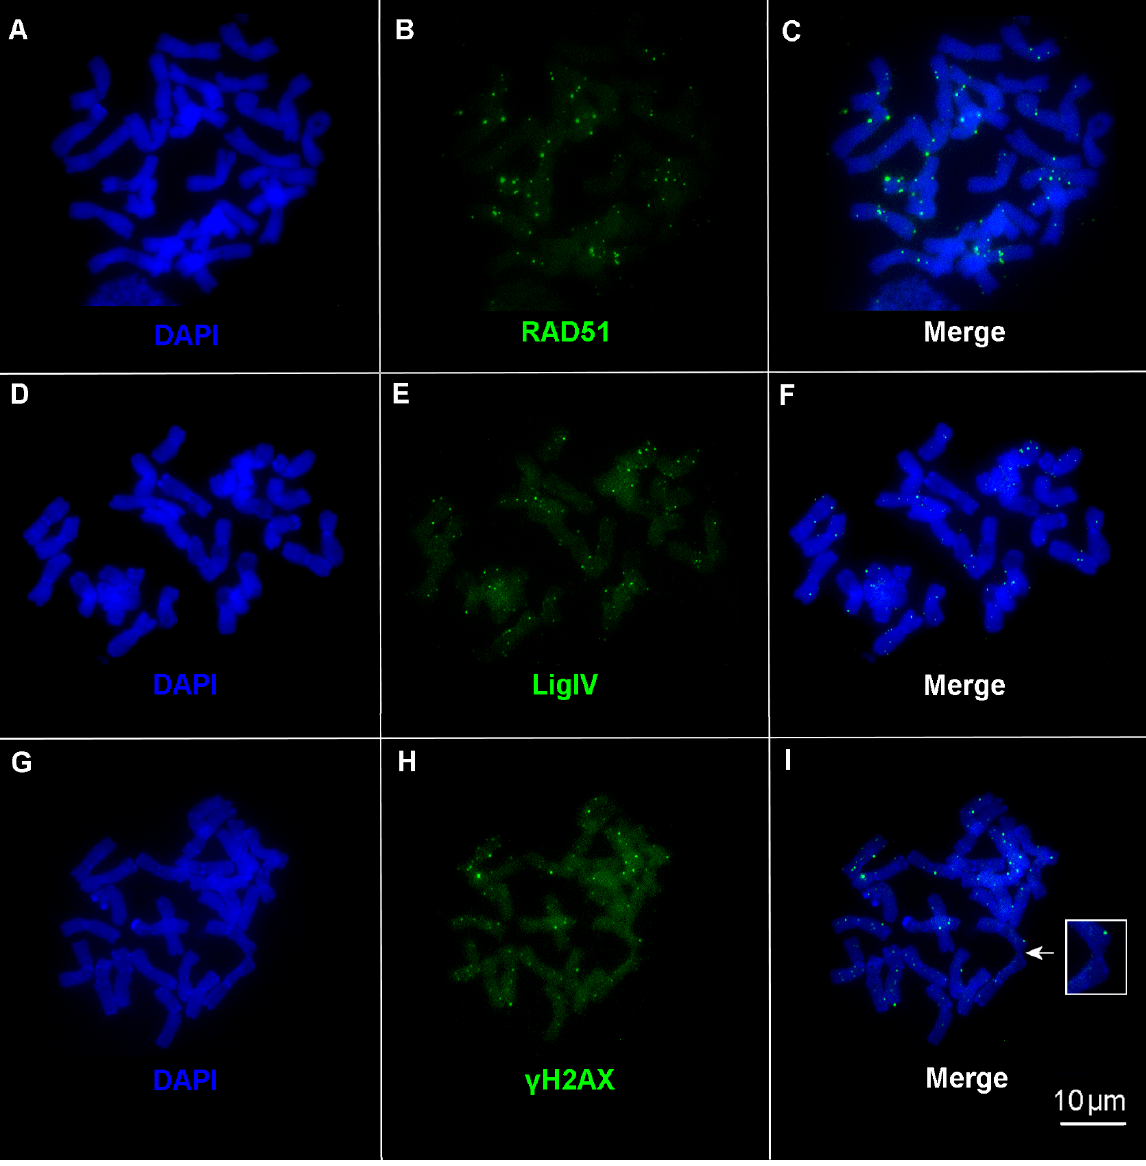
Figure 3. Immunodetection of RAD51, LigIV, and γ H2AX on metaphase chromosomes. ( A , D , G ) Coun- terstaining with DAPI. Immunofluorescent localization of ( A – C ) anti-RAD51 antibody; genotype TR52, ( D – F ) anti-LigIV antibody, genotype B81, and ( G – I ) anti- γ H2AX antibody; genotype B60. ( B , E , H ) Anti-rabbit Alexa Fluor ® 488-conjugated secondary antibody (green fluorescence) was used. ( I ) Ectopic association between chromosomes is indicated by an arrow (enlargement in the small box). Bar represents 10 µ